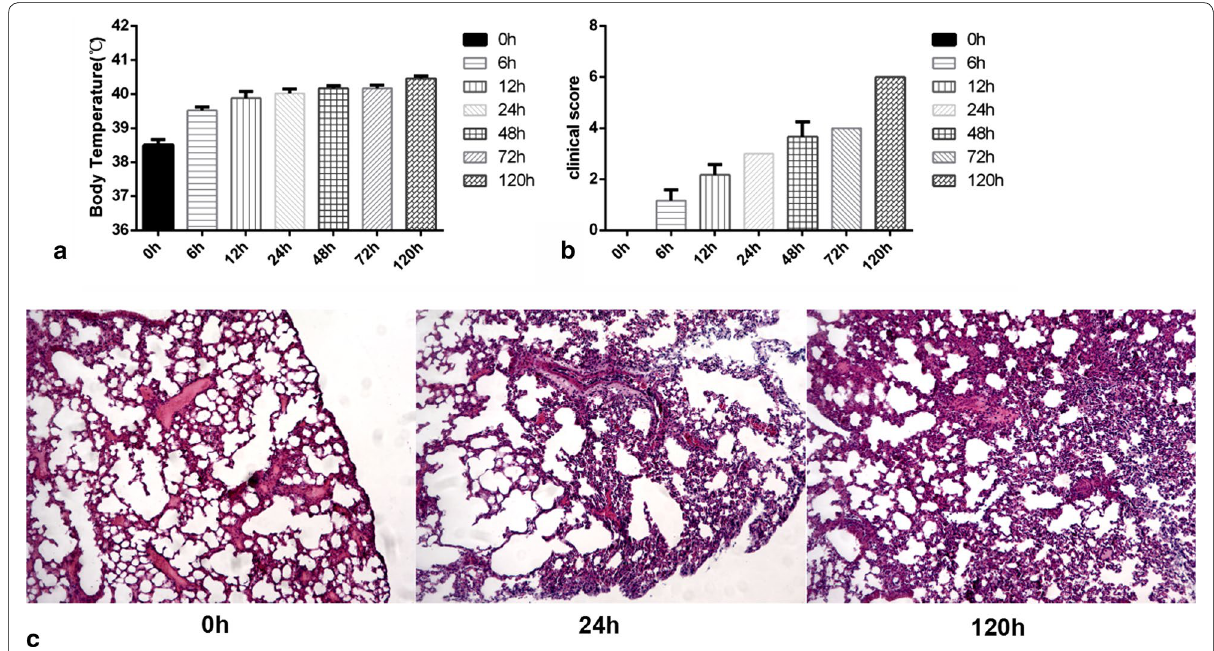
Fig. 1 Clinical symptoms of piglets at different time points after